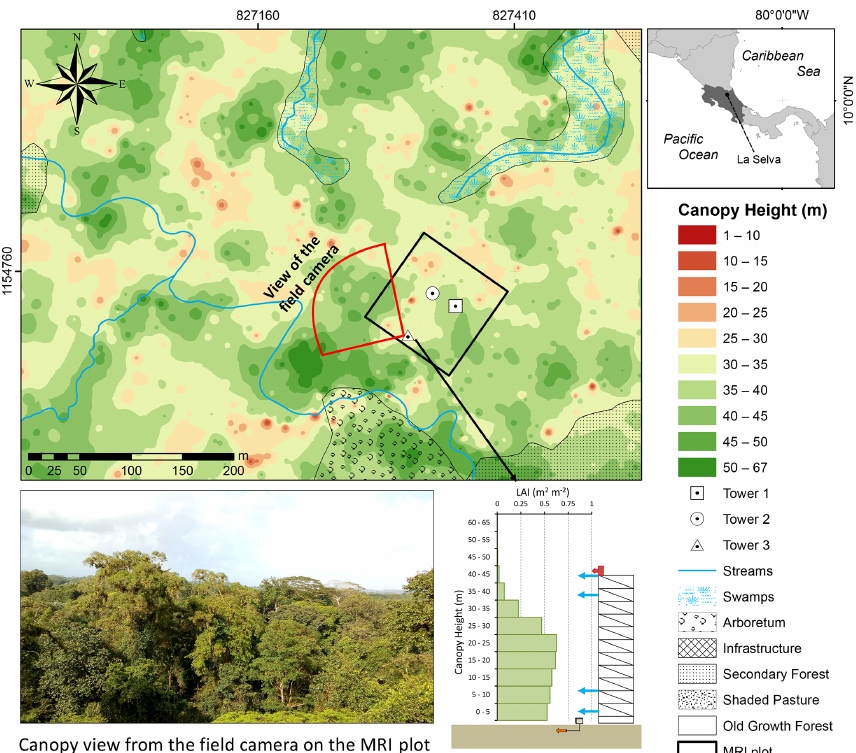
Figure 1. Canopy height and land cover map of the area surrounding the major research infrastructure plot (MRI plot) at La Selva Biological Station, Costa Rica. The photograph shows the view from the field camera at the top of the